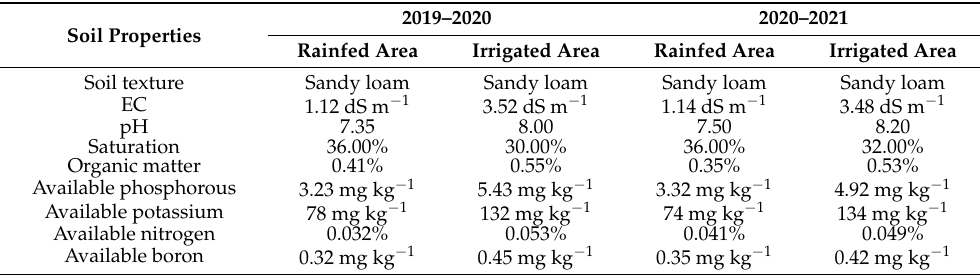
Table 1. Soil physical and chemical properties of experiment locations prior to the initiation of